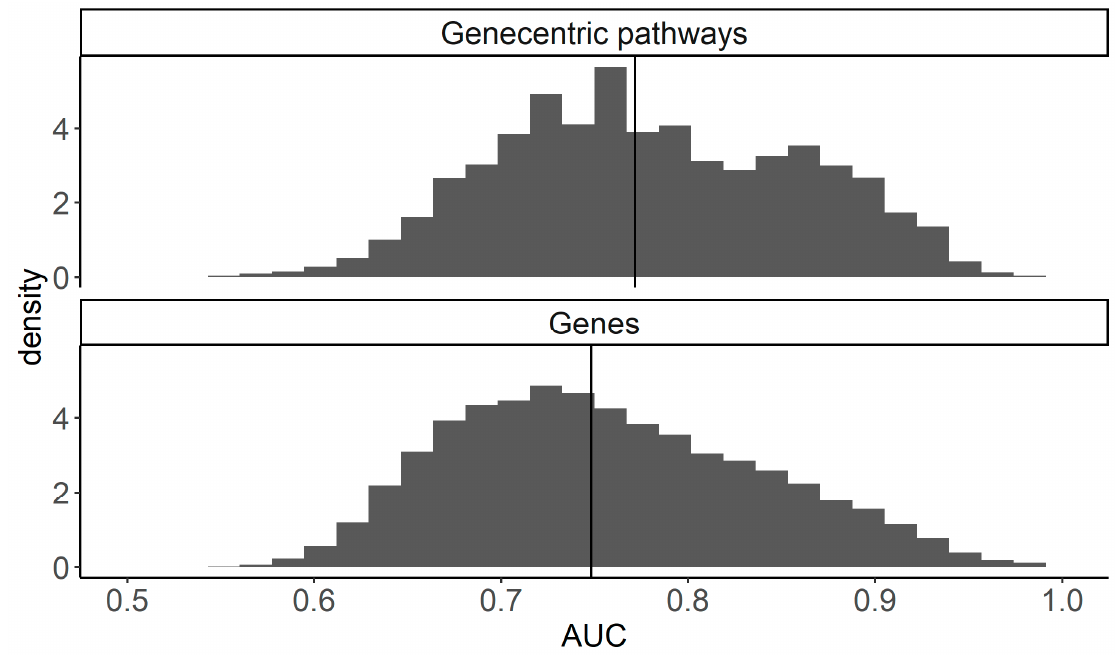
Figure 13. Distribution of maximal AUC values for expression-based biomarkers in the comparisons of GBM vs. LGG, Mesenchymal vs. proneural, classical vs. proneural, and mesenchymal vs. classical GBM molecular subtypes. The median of each distribution is shown by a marker